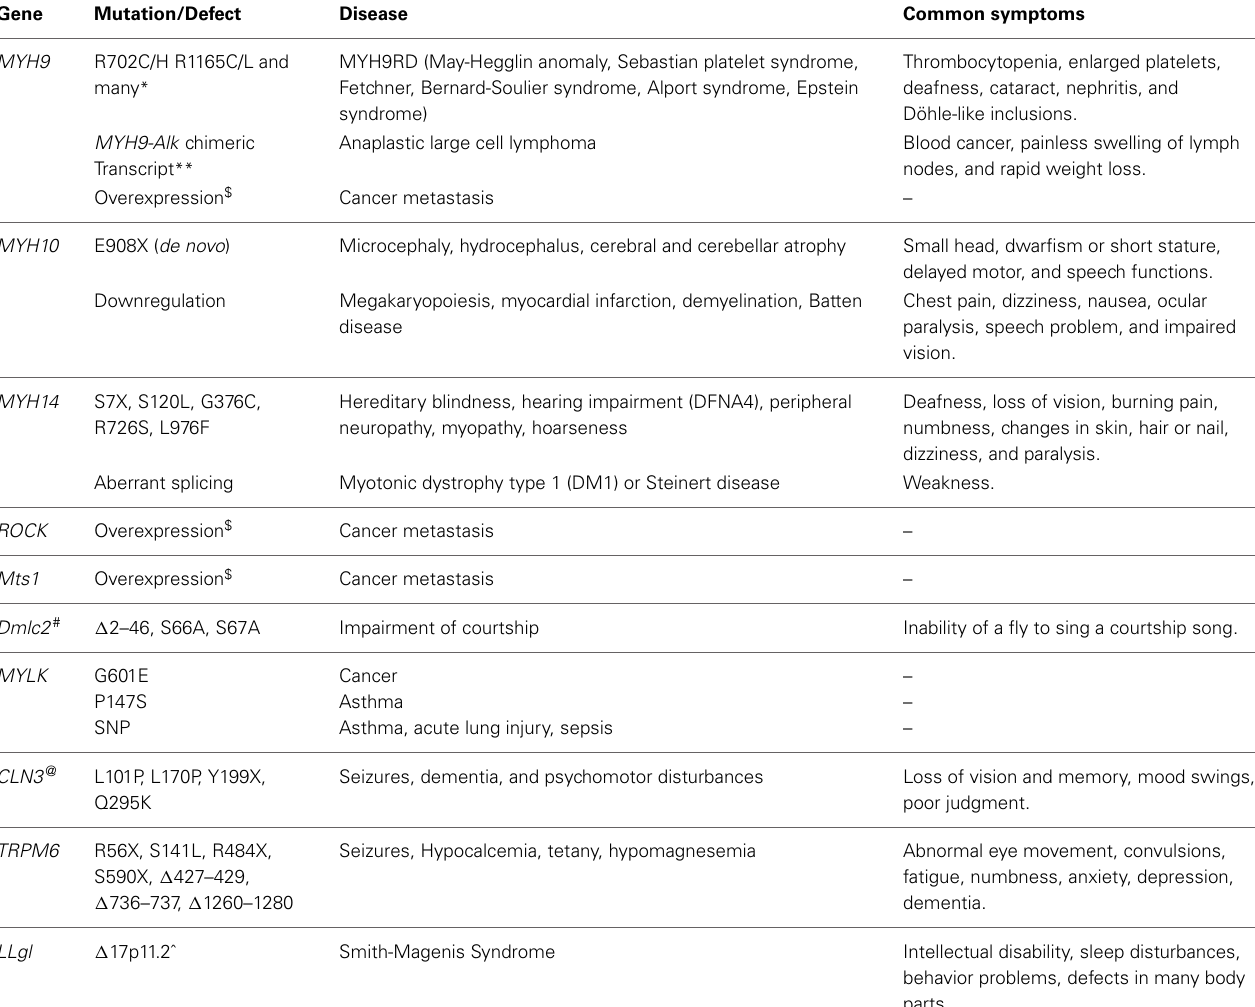
Table 1 | Defects and associated diseases of myosin II motor proteins and their regulators.